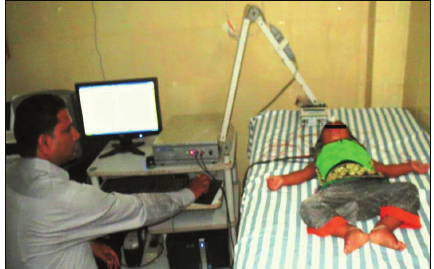
Figure 3: Audiologist performing brain evoked response audiome-